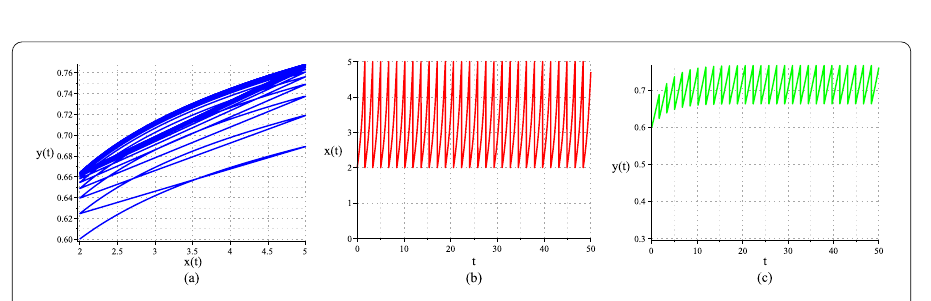
Figure 6 Numerical simulation of Example 3. (a) Phase portrait of x ( t ) and y ( t ) on h 2 = 5. (b) Time series of x ( t ). (c) Time series of y ( t ).